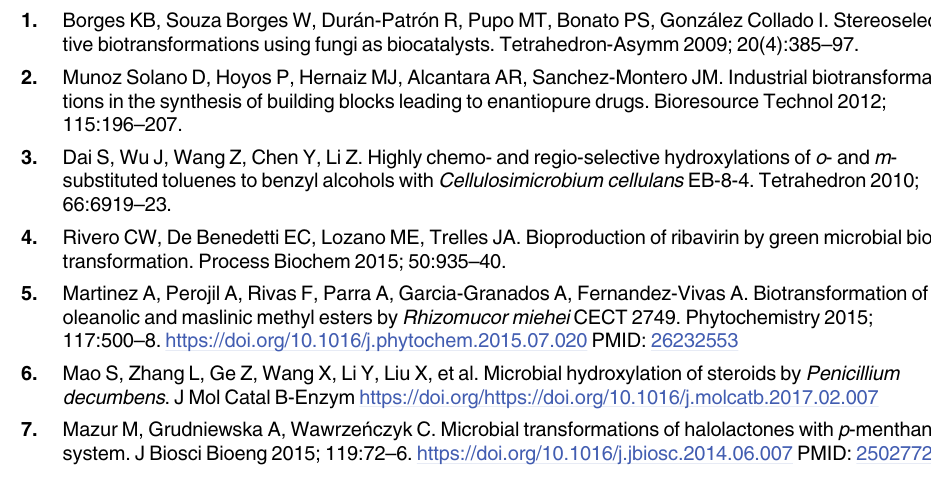
(PDF) S11 Fig. IR spectrum of hydroxychlorolactone 6. (PDF) S12 Fig. HRMS spectrum of hydroxychlorolactone 6.